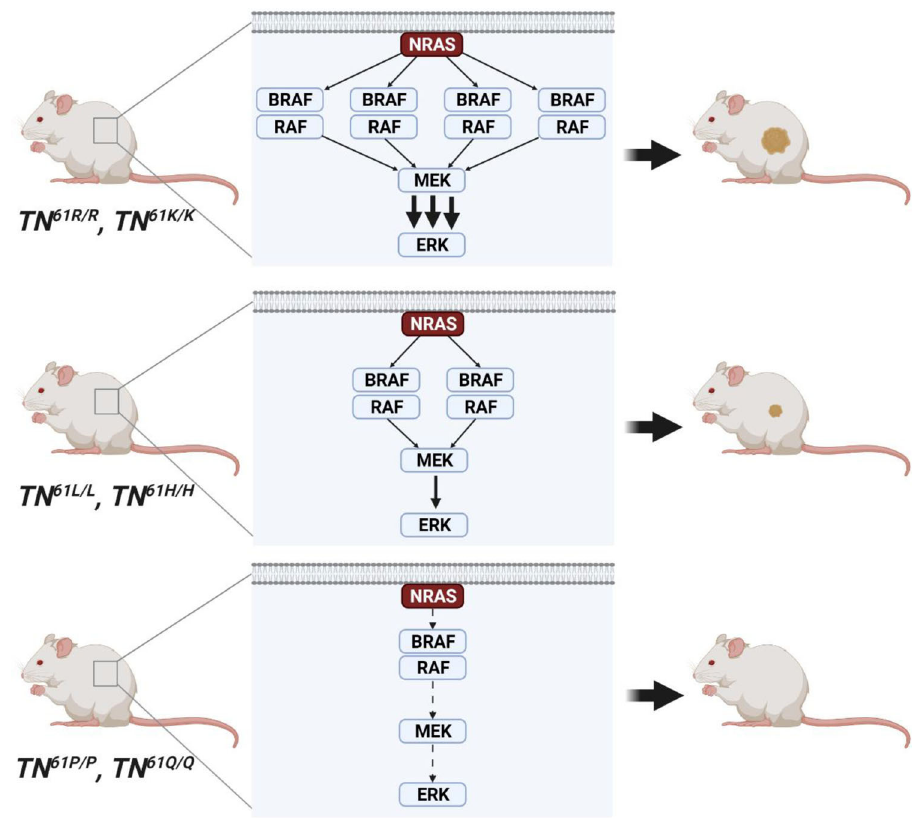
Fig. 8 Differential RAF engagement explains variances in the ability of oncogenic NRAS mutants to initiate melanoma formation. Image created with